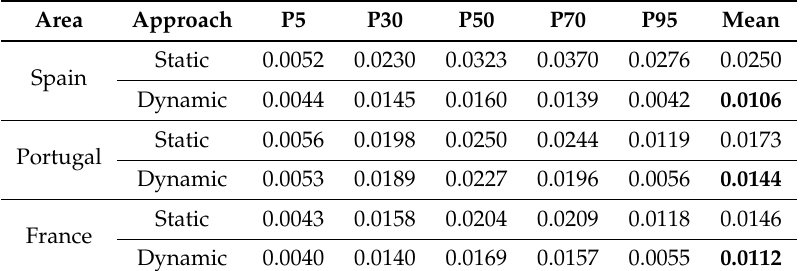
Table 5. Pinball loss function comparison on a monthly scale.